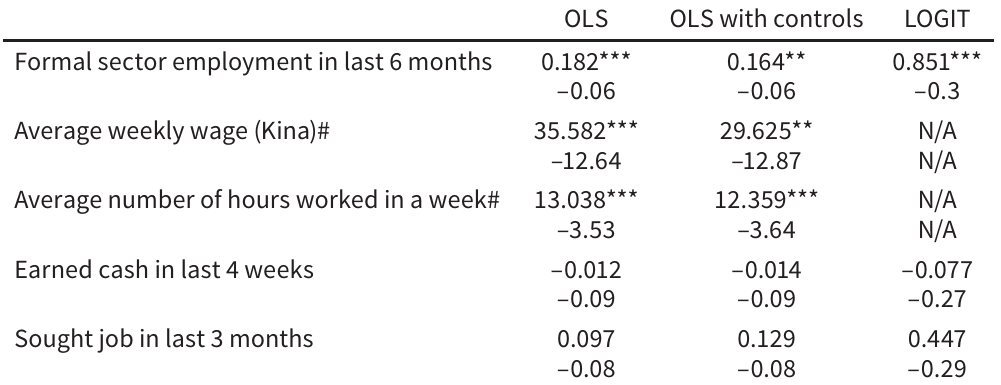
Table A3 Effect of the program using different econometric specifications OLS OLS with